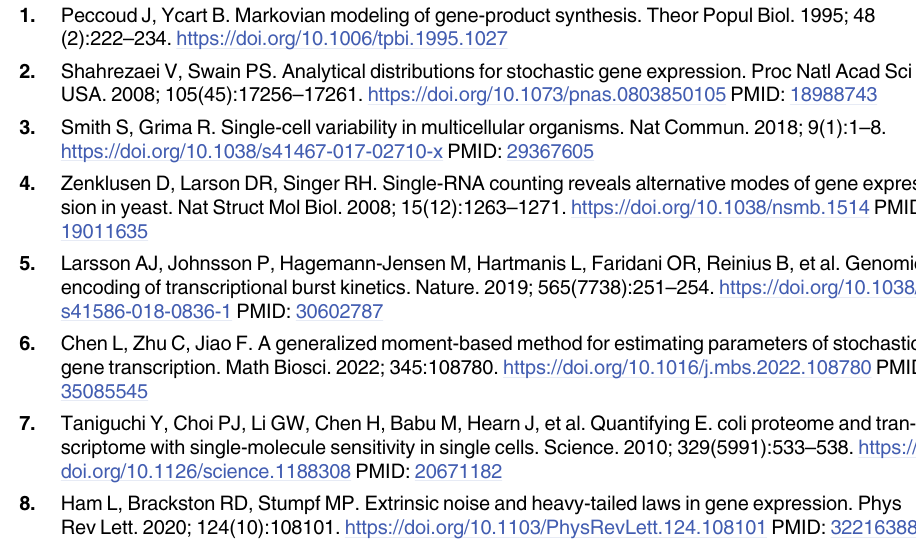
S6 Fig. Influence of two-layer cell-size control on concentration homeostasis and concen- tration noise for various choices of β and κ . A-C : Heat plot of the homeostasis accuracy γ (left panel) and concentration noise ϕ (right panel) versus the strengths of size control, α and 0 α 1 . The model parameters are chosen as N = 50, N 0 = 21, ρ = 4.7, B = 1, d = 0.4, η = 4. S7 Fig. Cell volume distribution in budding yeast. The blue curve shows the volume distribu- tion of all cells. The green curve shows the distribution of cells in the G phase and the yellow 1 curve shows the distribution of cells in the G /S/M phase. The data shown are published in 2 [92]. S8 Fig. Copy number and concentration distributions of three mRNAs in budding yeast. A : The mRNA copy number (red curve) and concentration (blue curve) distributions for the HTB1 gene. The green curves show the distributions of cells in the G 1 phase and the yellow curves show the distributions of cells in the G /S/M phase. B : Same as A but for the ACT1 2 gene. C : Same as A but for the HHF1 gene. The data shown are published in